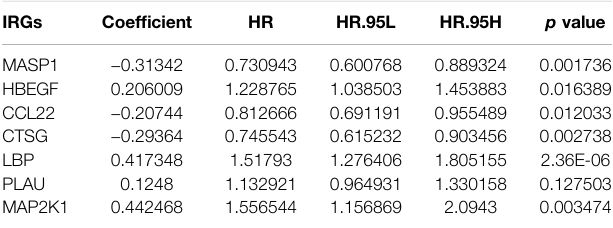
TABLE 1 | Multivariate cox regression analysis of characteristic IRGs among OSCC patients in the TCGA cohort.